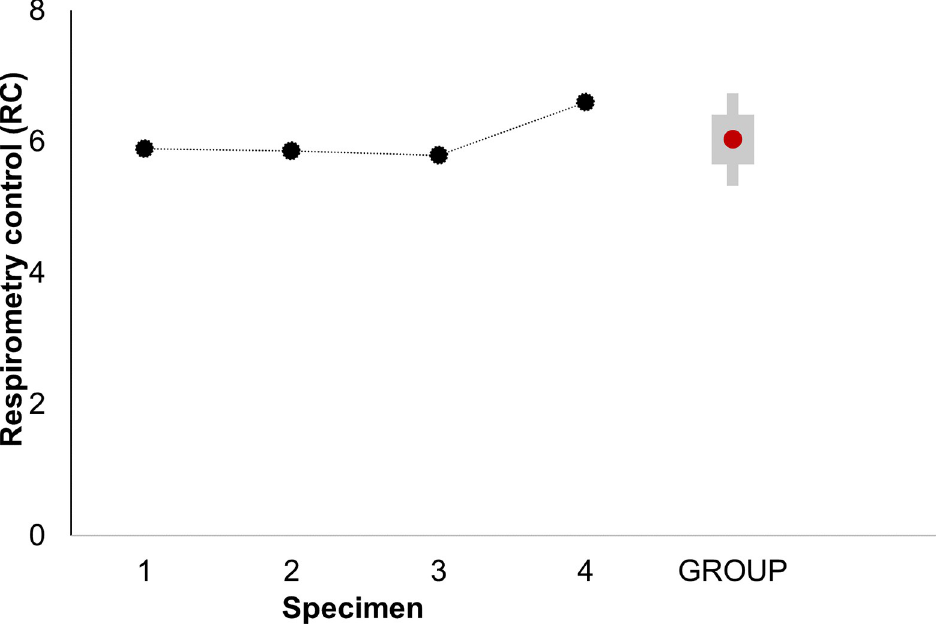
Fig 1. Respiratory control parameter (RC) of isolated mitochondria from the systemic heart of Octopus maya . The RC of systemic heart mitochondria was obtained from the ratio of respiratory states 3 (S3) and 4o (S4o) once corrected for the respiratory state ROX (S3 = S3’-ROX and S4o = S4’o-ROX). The RC is calculated individually (black dots) for each adult O . maya specimens (N = 4, mean weight 1 348 ± 263.49 g) using a mitochondrial concentration of 377 ± 0.02 μ g ml -1 . GROUP; represents the mean RC value of the four specimens (red dot), ± SD (gray box).